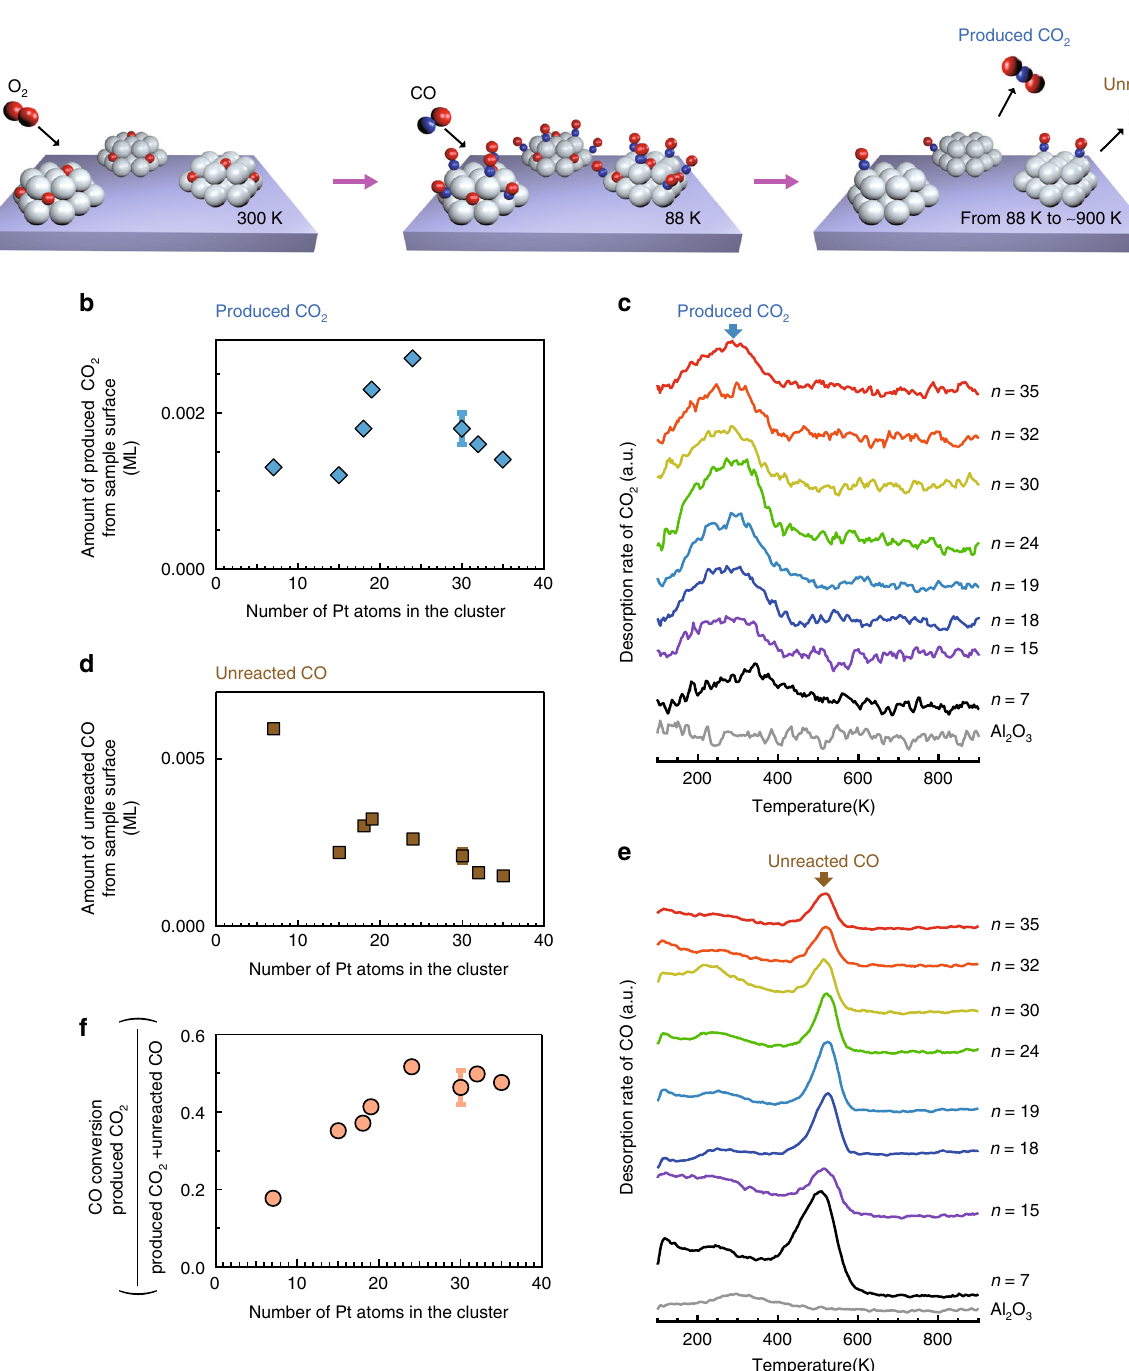
Fig. 1 CO oxidation activity of mass-selected Pt n clusters on Al 2 O 3 . a Overview of the CO 2 temperature-programmed reaction (TPR) measurements. The Pt n -deposited surfaces were exposed to 1000L of 18 O 2 at 300 K to saturate the Pt n clusters with 18 O atoms, followed by saturation adsorption of 13 CO at 88 K, and fi nally the TPR measurement was performed. The Pt coverage was 0.02 ML. b Amount of produced CO 2 from sample surface with mass-selected Pt single clusters relative to the number of Pt atoms in the cluster. The error bars were determined from multiple measurements on a single cluster size. c CO 2 TPR spectra ( m / z = 47) over Pt n /Al 2 O 3 . The number of produced CO 2 molecules was estimated by integrating the intensity between 100 and 500 K. d Amount of unreacted CO molecules relative to the number of Pt atoms in the cluster. e CO TPR spectra ( m / z = 29) over Pt n /Al 2 O 3 . f CO conversion (ratio of produced CO 2 molecules to adsorbed CO molecules) as a function of the number of Pt atoms in the cluster. The error bars in b , d , and f are standard deviation. Source data are provided as a Source Data fi